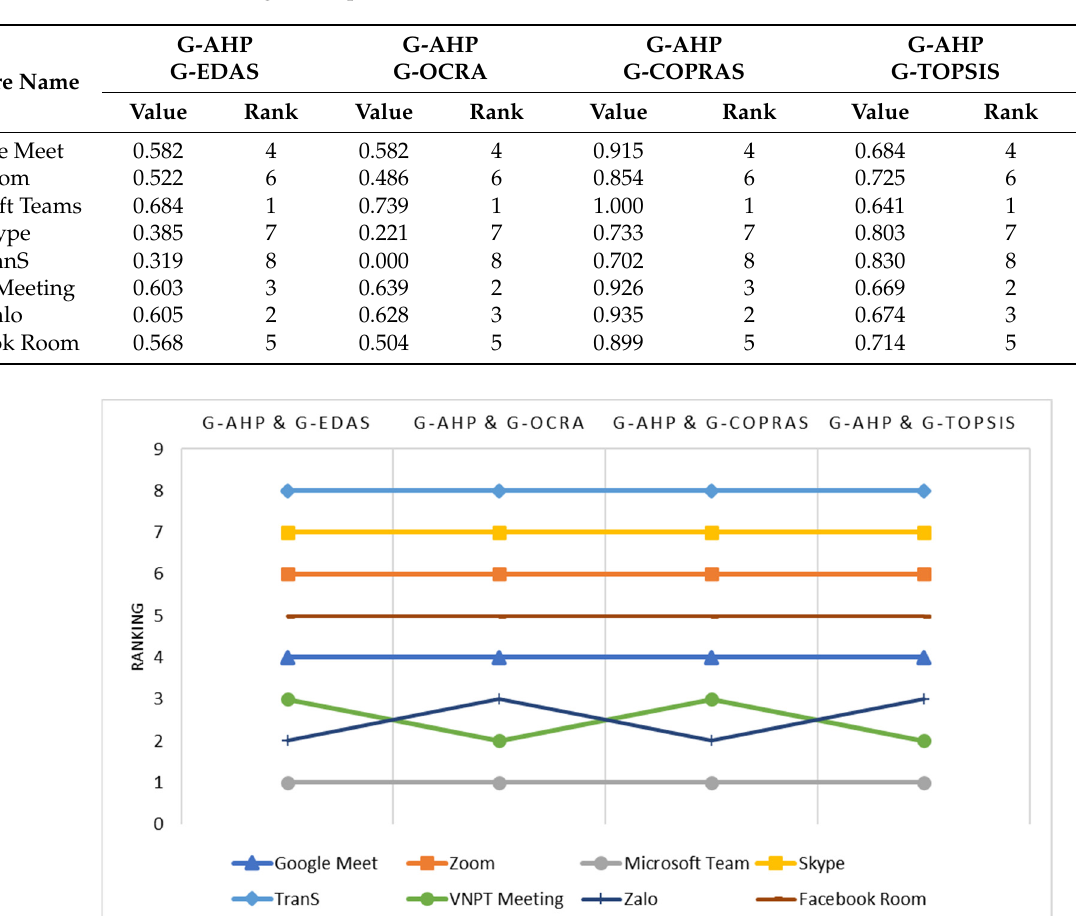
Figure 7. Comparative analysis of methods.